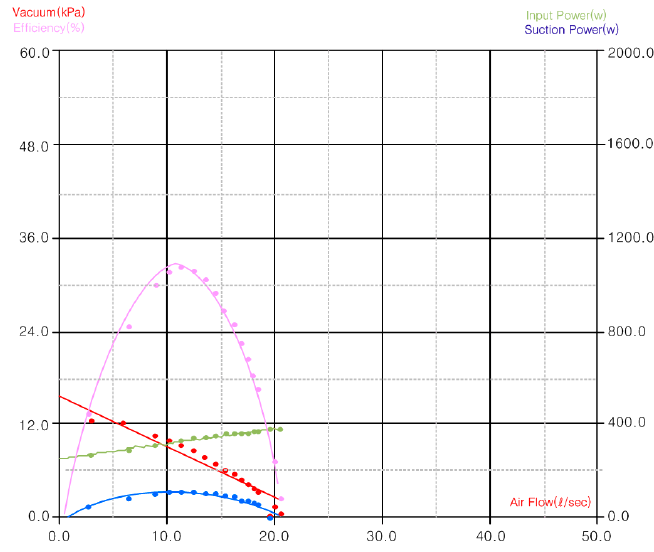
Figure 22. DC Motor suction power graph.